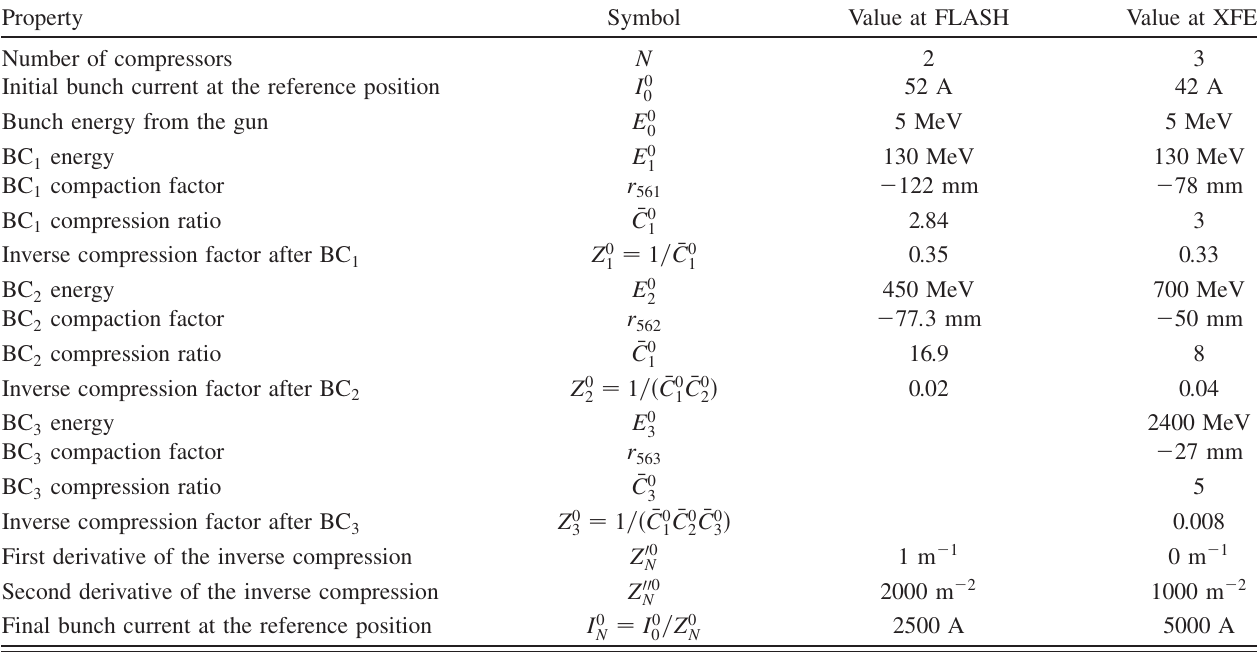
TABLE I. Parameters describing the compression schemes at DESY for nominal bunch charge of 1